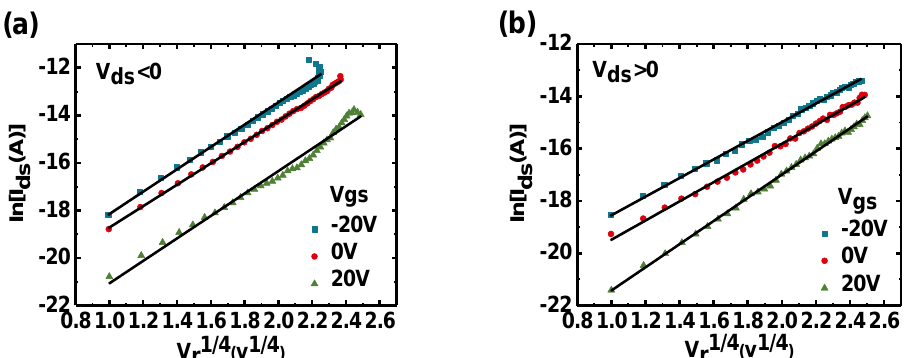
√ | V | . ( a ) Reverse direction (V r